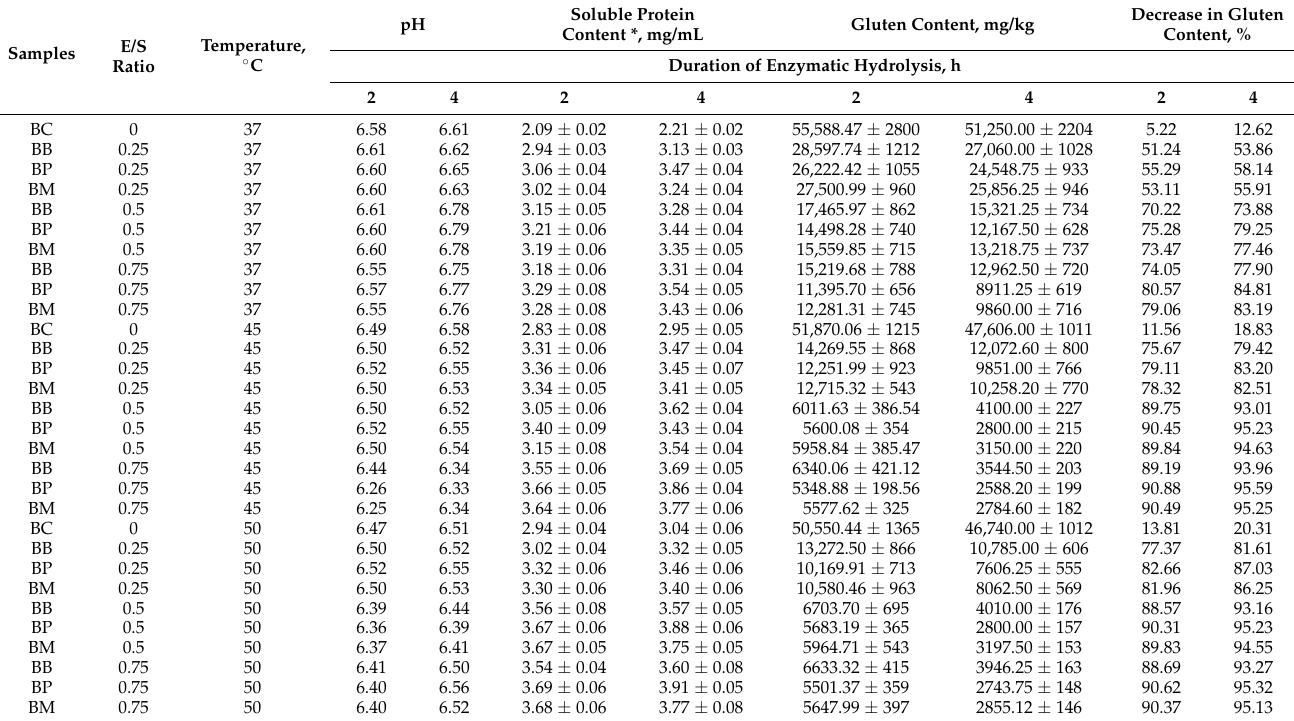
Table 1. PH, soluble protein, and gluten content in wheat bran substrates after 2–4 h enzymatic hydrolysis under different conditions.